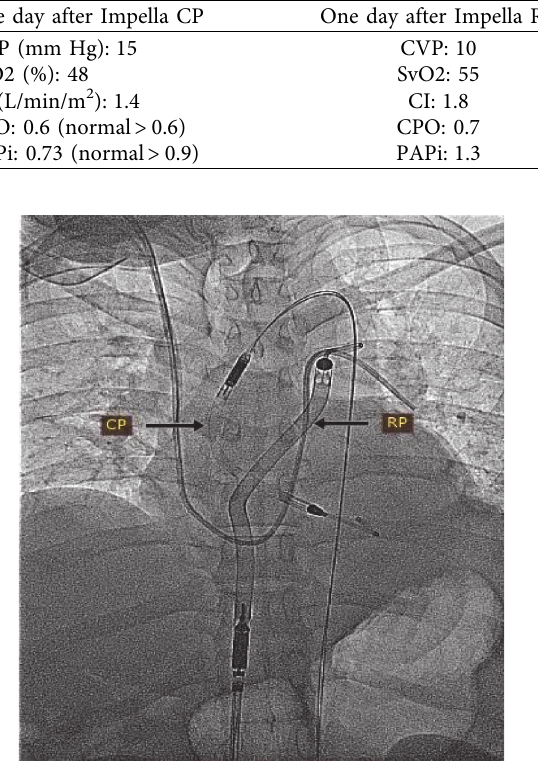
Figure 1: A fluoroscopic image showing the Bi-Pella configuration using the Impella CP and Impella RP axial flow